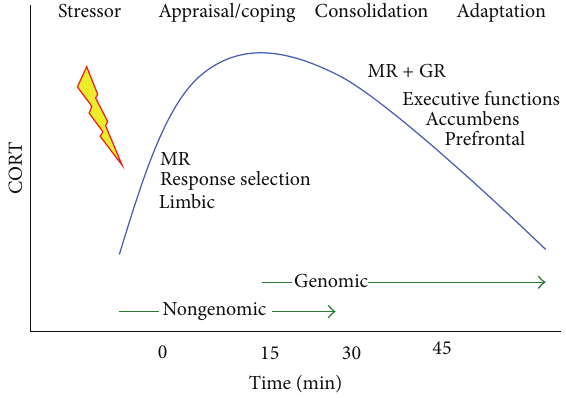
Figure 3: Corticosterone action during processing of stressful information. Increasing corticosterone concentration induced by a stressor initially activates MR modulating appraisal processes and immediate coping and then progressively activates also nuclear GR to reallocate energy to circuits underlying consolidation and reten- tion of the experience in the memory [58]. For this purpose MR and GR mediate in complementary fashion the action of corticosterone in hippocampus and amygdala from decision-making and cognitive flexibility to executive functions in prefrontal brain regions, as is mediated by the mesolimbic dopaminergic system innervating the nucleus accumbens. Adapted from de Kloet et al. [13]. MR is mineralocorticoid receptors; GR is glucocorticoid